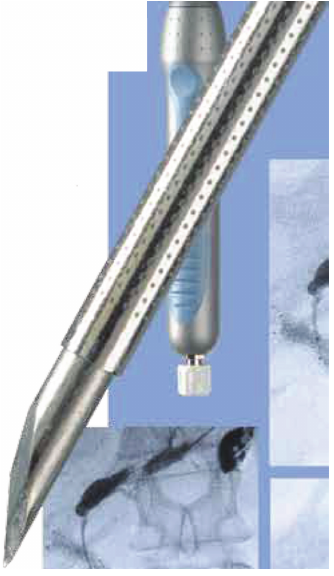
Figure 2: Echotip “ACCESS NEEDLE” Cook